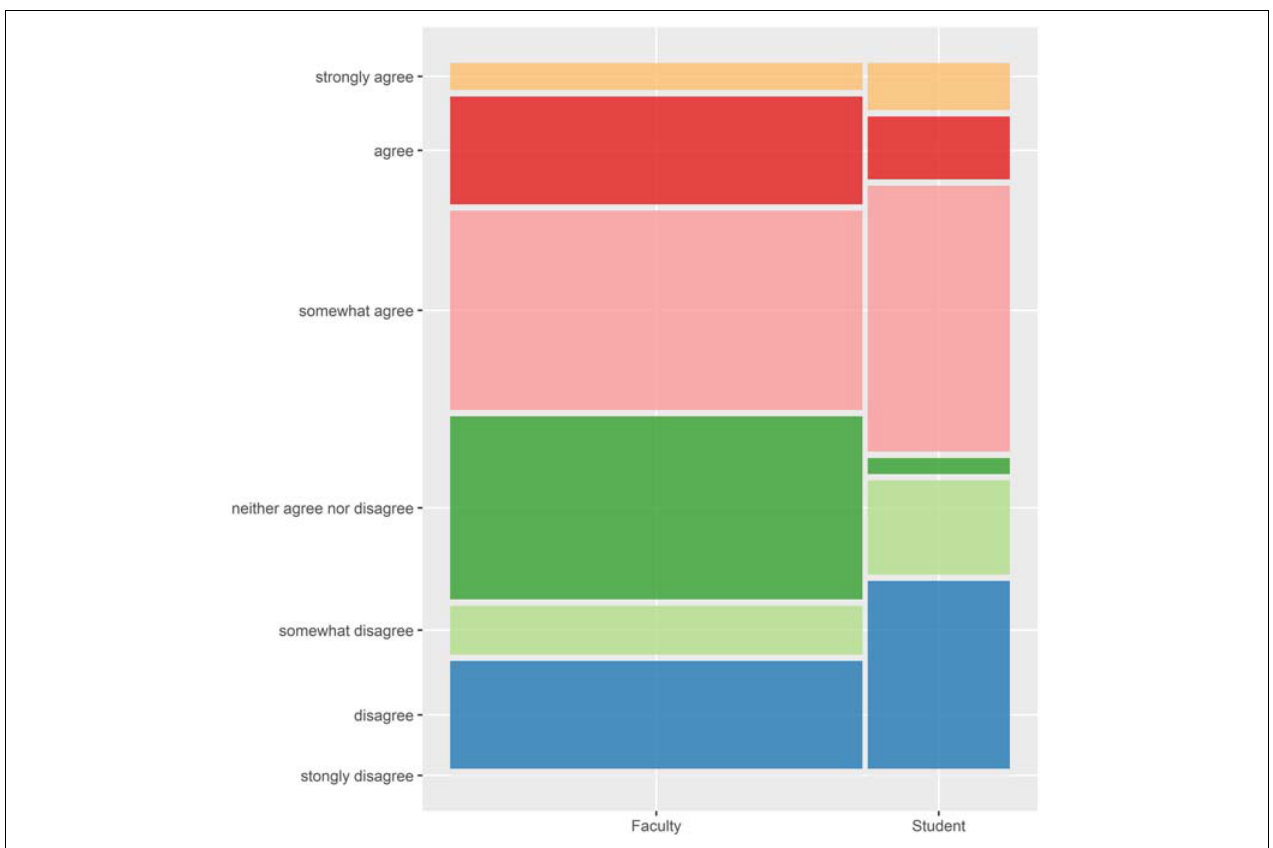
FIGURE 1 | Faculty and student responses to: Proctoring software in online tests is effective at preventing academic